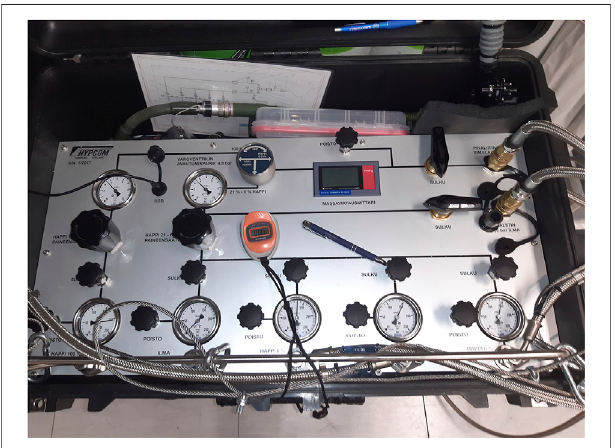
FIGURE 1 | Hypoxic gas selection box (Hypcom, Tampere, Finland).